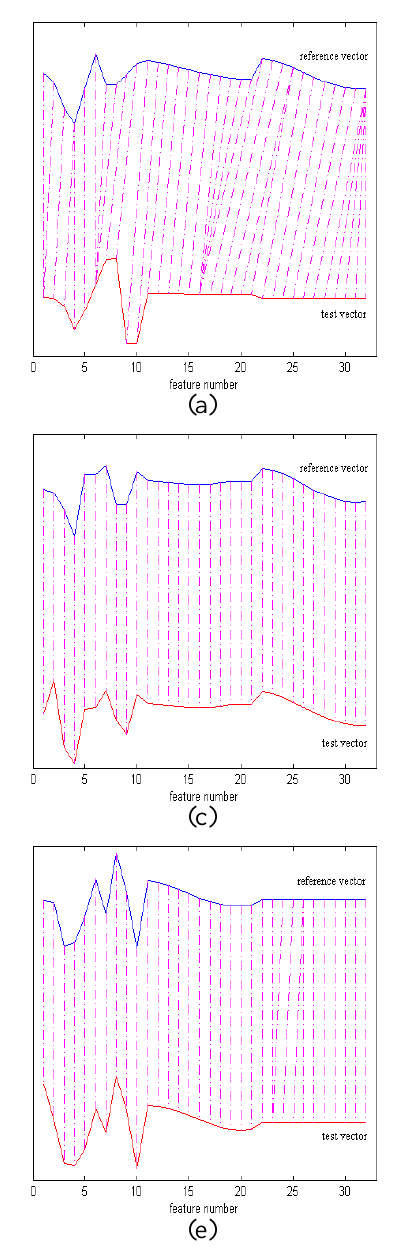
Figure 11. In (a), (c), and (e), the upper curves show reference vectors and the lower curves represent test vectors of size 32 £ 1 . Parts (b), (d), and (f) illustrate the least-cost warp paths between the two feature vectors, respectively. In (a), reference and test vectors are from different classes. In (c) and (e), both the reference and the test vectors are from the same